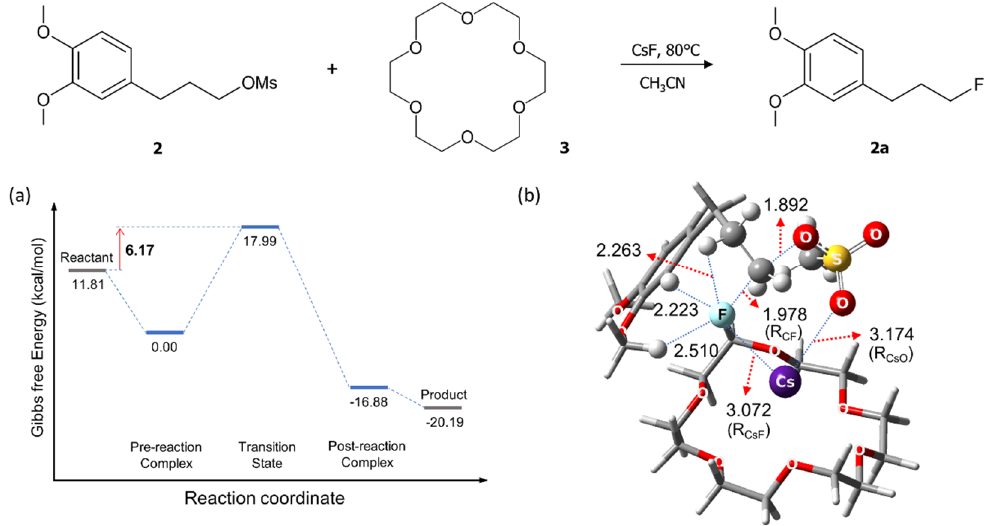
Figure 4. ( a ) Energetics and ( b ) structure of the transition state for S N 2 fluorination of 2 in the presence of 3 (18-crown-6). Gibbs free energy in kcal/mol, and bond lengths in